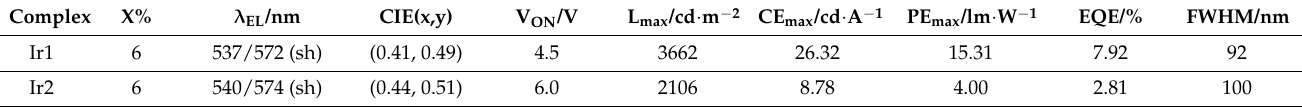
Table 3. EL data for the yellow OLEDs based on Ir1 and